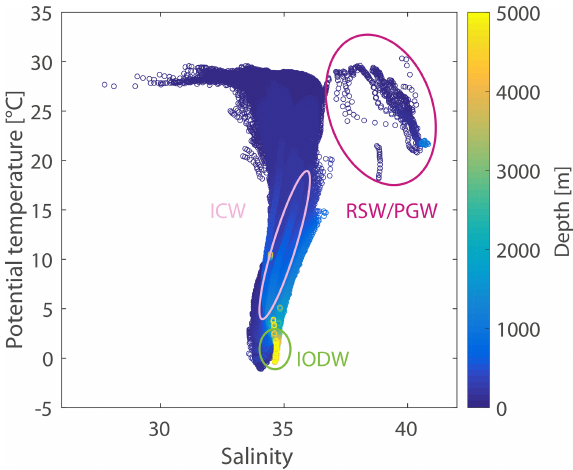
Figure 3. T – S diagram of the Indian Ocean from observational data (WOA13) colour-coded by depth. The source water masses for the water mass mixing analysis are Indian Ocean Deep Water (IODW), Indian Central Water (ICW), and Red Sea and Persian Gulf Water (RSW/PGW). The ovals indicate the approximate T – S ranges of the respective water masses. Exact values of the water mass properties used in this study can be taken from Fig. 4 and Table